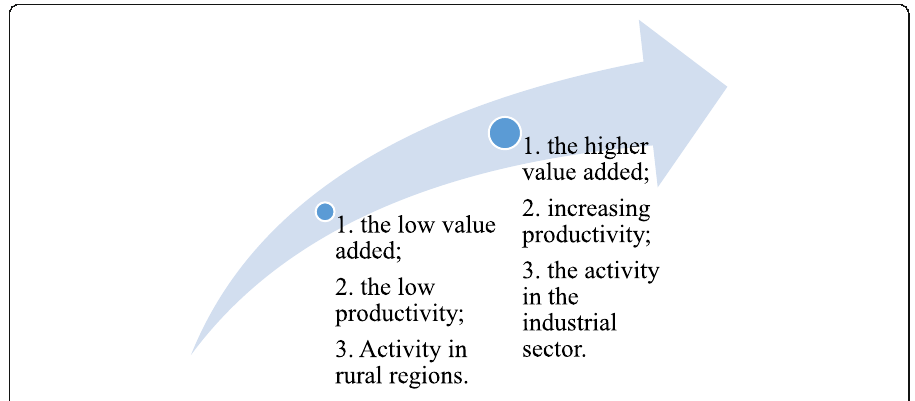
Fig. 1 The graphical view of the structural transformation of production and consumption (Source: compiled by authors based on Bale ž entis